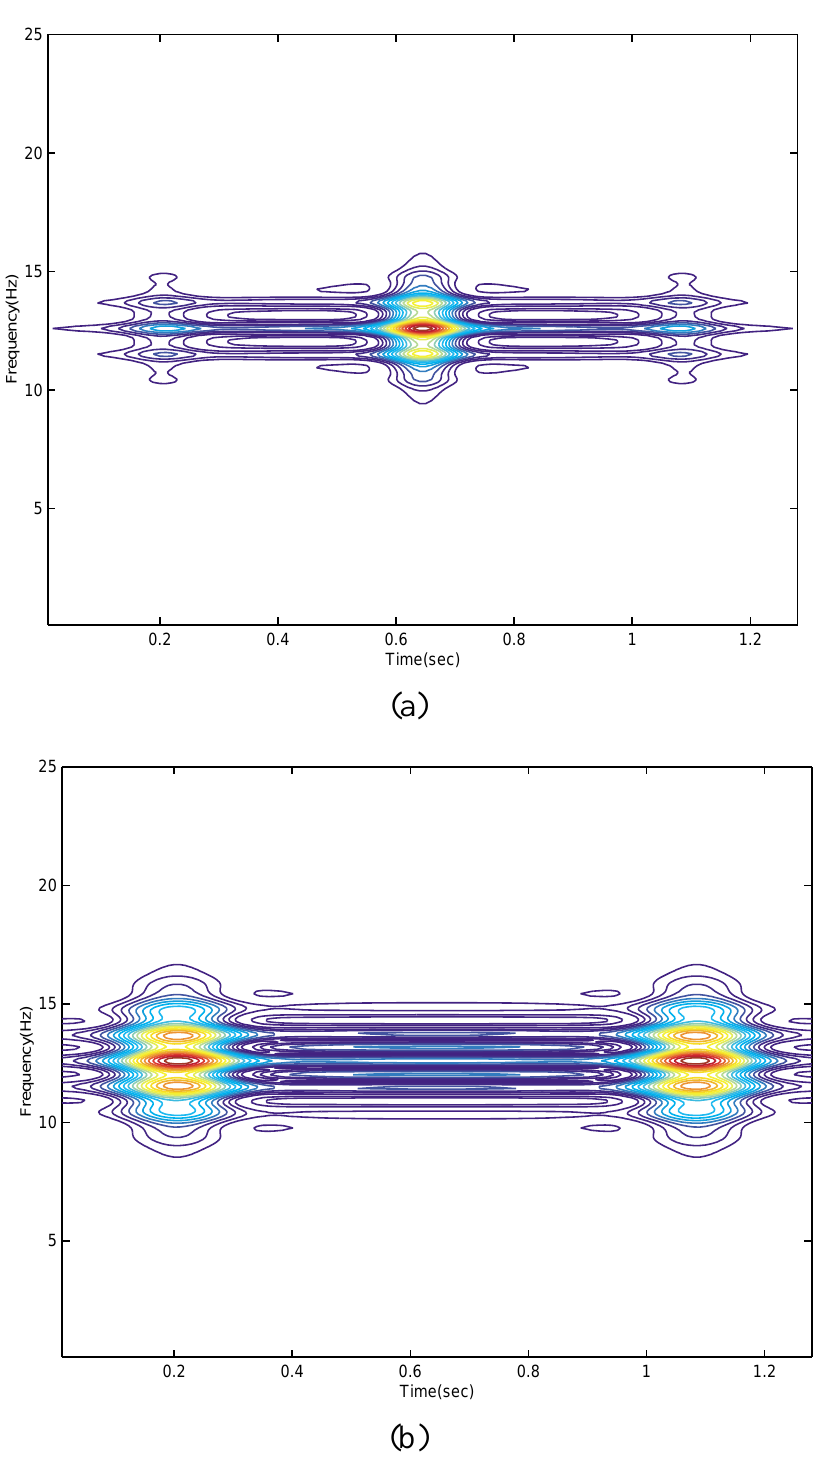
Fig. 3. Comparison between the WVD and SWFOMS for the two component signals centered at 0.2 s and 1.08 s with 12.5 Hz. (a) The WVD weighted by an exponential kernel. (b) The SWFOMS weighted by an exponential